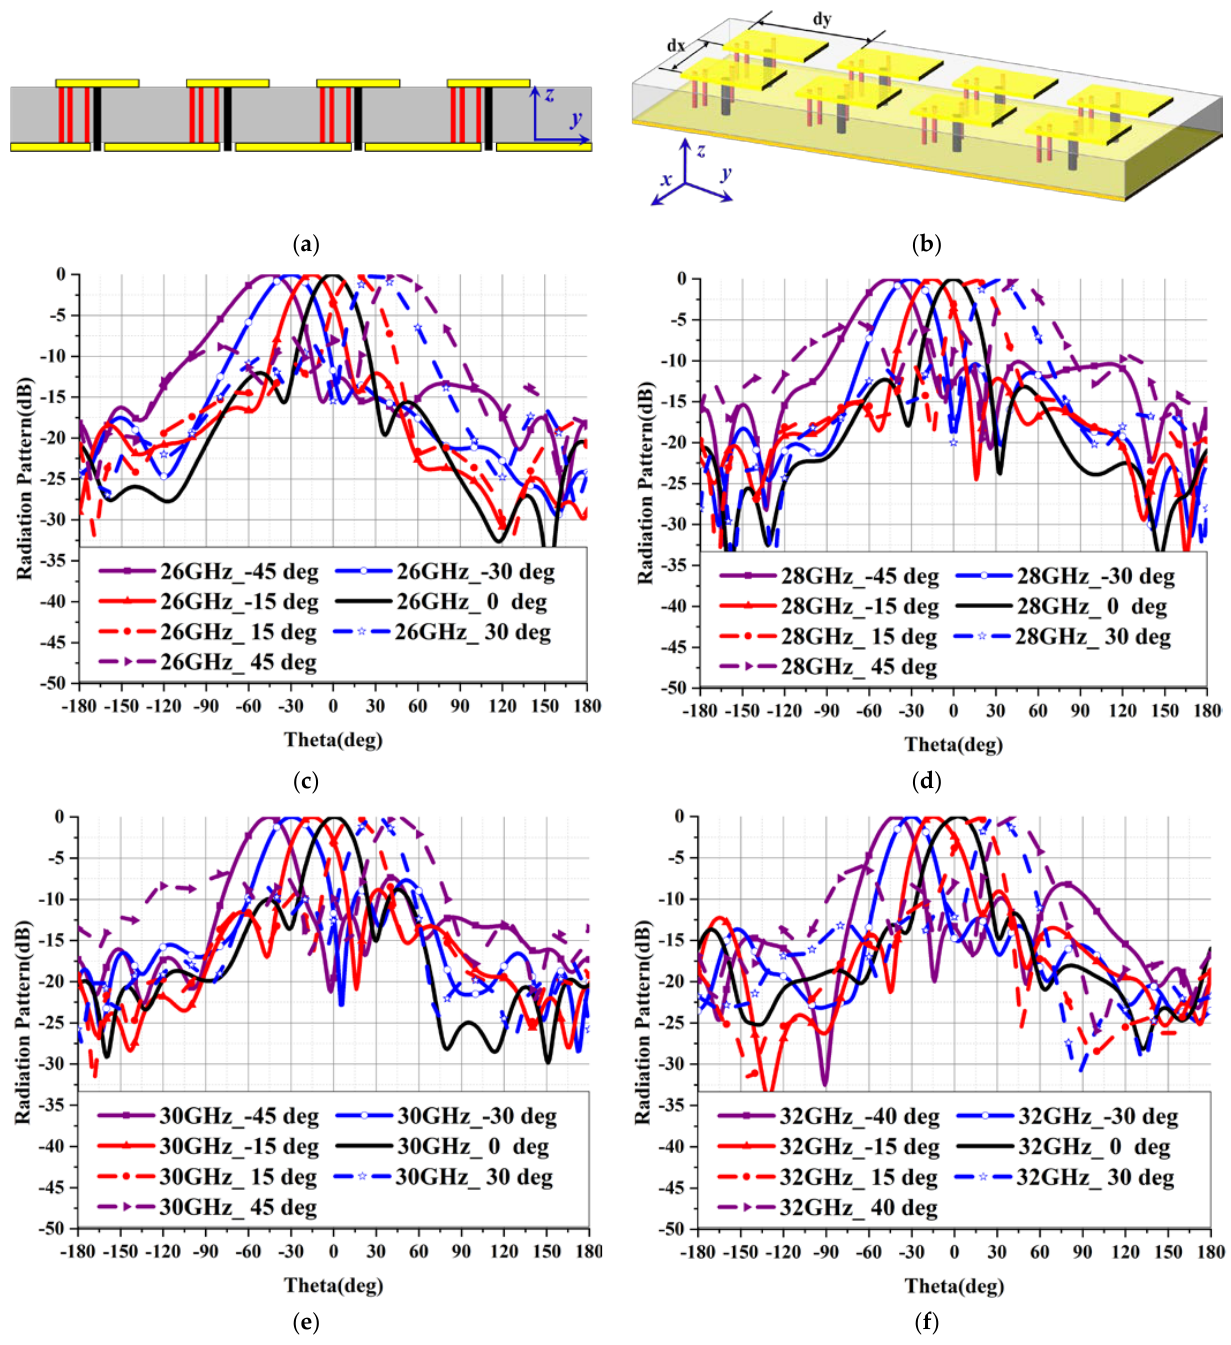
Figure 6. Antenna array and simulated performances of beam scanning. ( a , b ) Side view and 3D view of antenna array. ( c – f ) Beam scanning performances of 26 GHz, 28 GHz, 30 GHz and 32